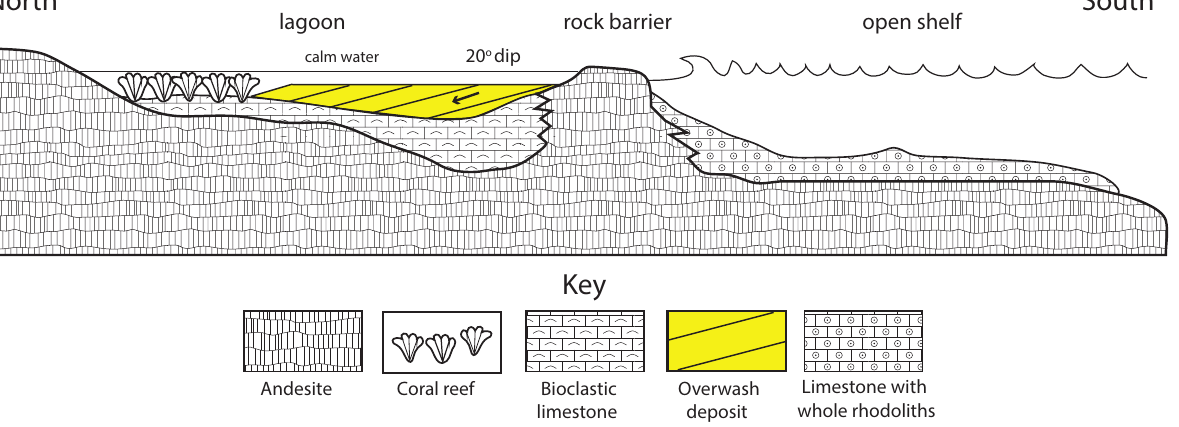
Figure 7. Cross-section through a Late Pleistocene lagoon uplifted on the south shore of Isla Coronados, showing an overwash deposit with multiple layers representing individual storm events that arrived from the south and left a succession of tilted beds off-lapped to the north